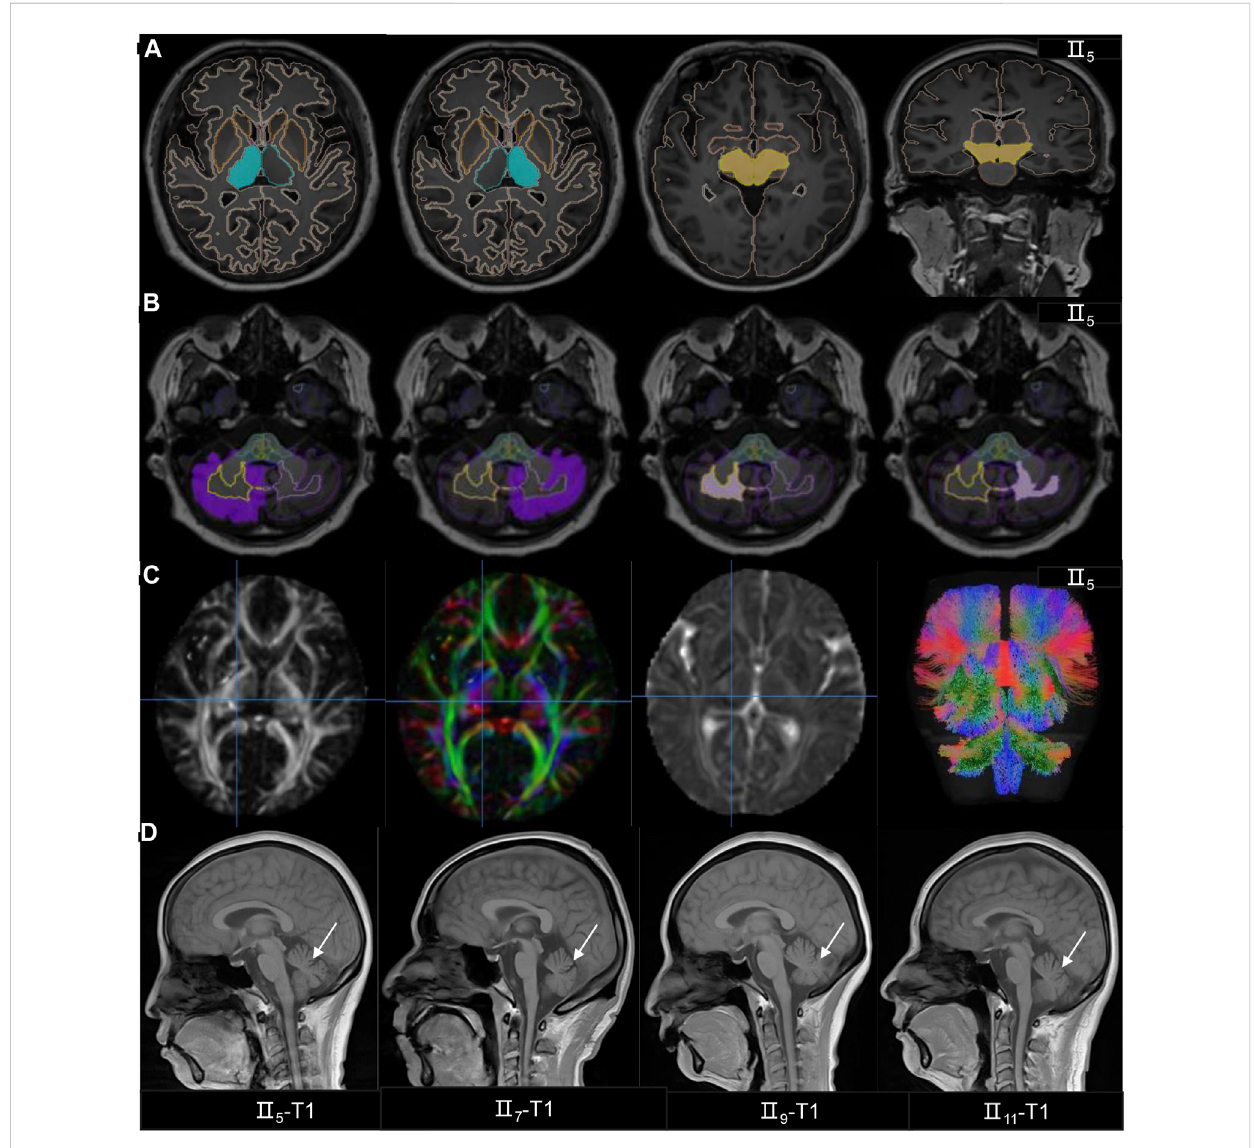
FIGURE 2 The MRI fi ndings of the SCA family. (A – B) The 3D-T1 analysis showed the patient ’ s (II 5 ) midbrain and thalamus volumes were normal, but the volumes of gray matter and white matter volumes in the cerebellum had decreased. (C) The patient ’ s (II 5 ) DTI analysis showed the FA, DEC, AD and